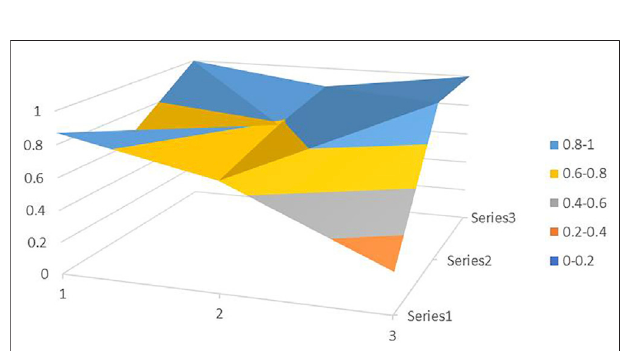
constructing a surface plot of the mean values of the PMC indices of the primary variables of national park policies in the three regions, we can visually and three-dimensionally show the overall situation of national park policies in the three regions, and at the same time, we can show the high and low mean values of the primary indicators of national park policies in the three regions, as shown in Figure 2 , Figure 3 and Figure 4 . First of all, judging from the color of the mean surface map of the PMC index of the national park policies in the three regions, blue indicates the highest score area. Obviously, Singapore has the largest proportion of blue in the surface map, followed by Hong Kong, and fi nally Hainan. This indicates that Singapore has a large share of high mean PMC values for the national park fi rst-level policy indicators. Secondly,